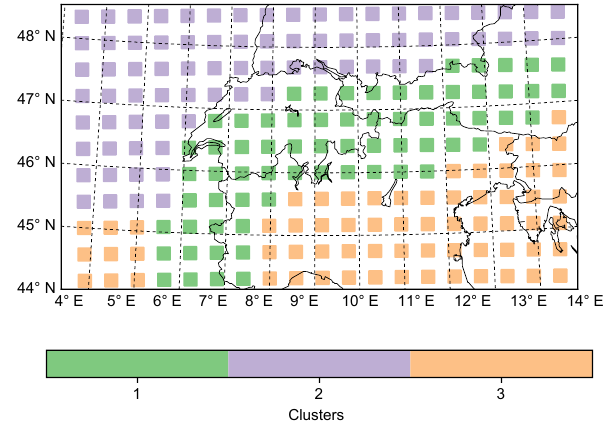
Figure 4. Hierarchical clustering of the 209 regions into three clusters based on the meteorological and topographical descriptors listed in Table